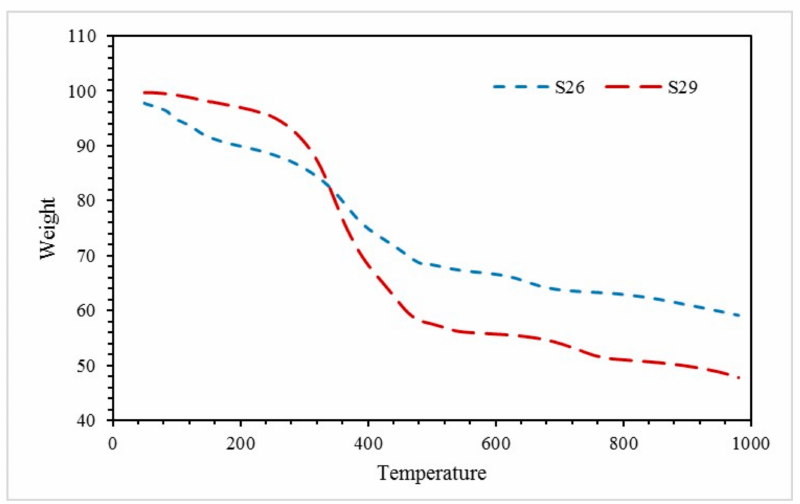
Figure 10. TGA of sample S26 and S29 in the fire resistance